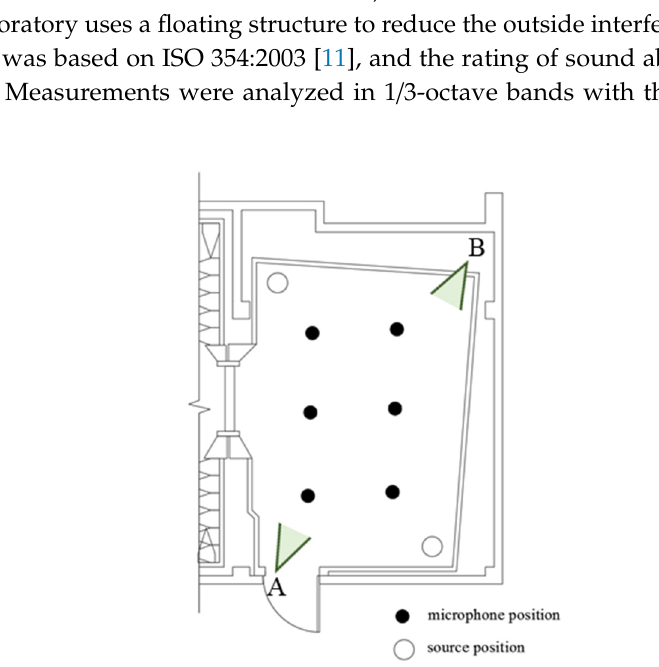
Figure 2. Reverberation room plan.